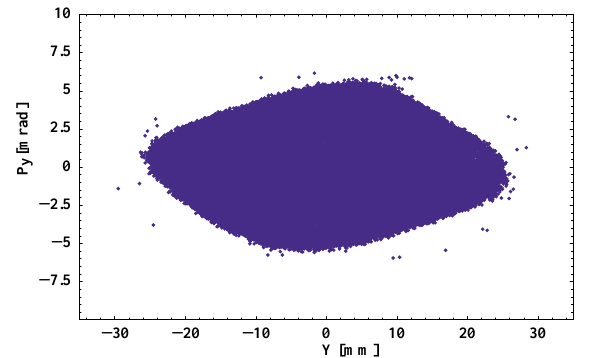
FIG. 8. Spectrum of (cid:5) y 3 (cid:6) at 375 turns for (cid:1) n x , n y (cid:2) (cid:1) (cid:1) 5.57, 5.54 (cid:2) .